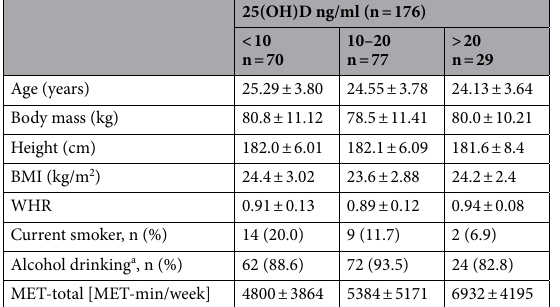
Table 1. Baseline characteristic of the study groups. Values are expressed as frequency (%) or mean ± SD. BMI body mass index, WHR waist–hip ratio, MET-total total energy expenditure. a Beer, wine, or spirits in the amount equivalent ≥ 50 g ethanol per